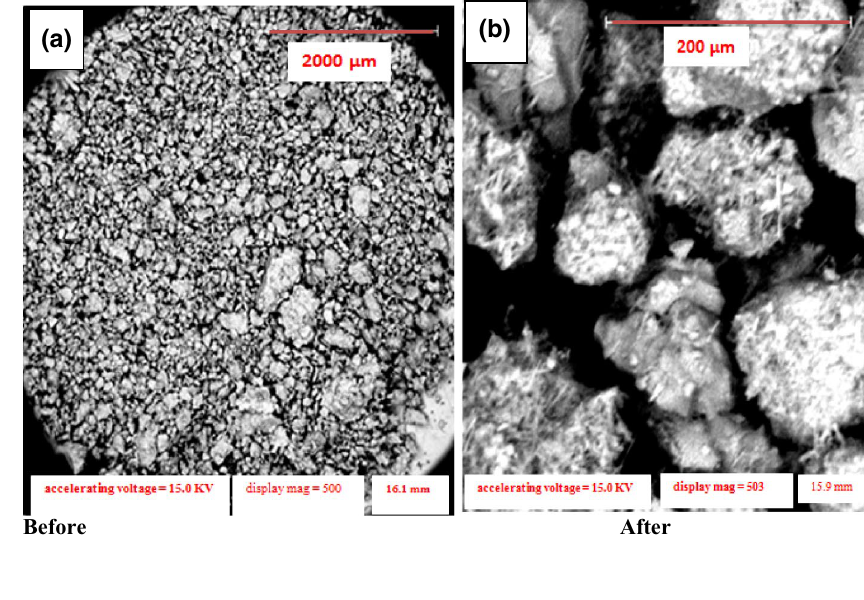
Fig. 10 SEM micrograph of OSA before and after